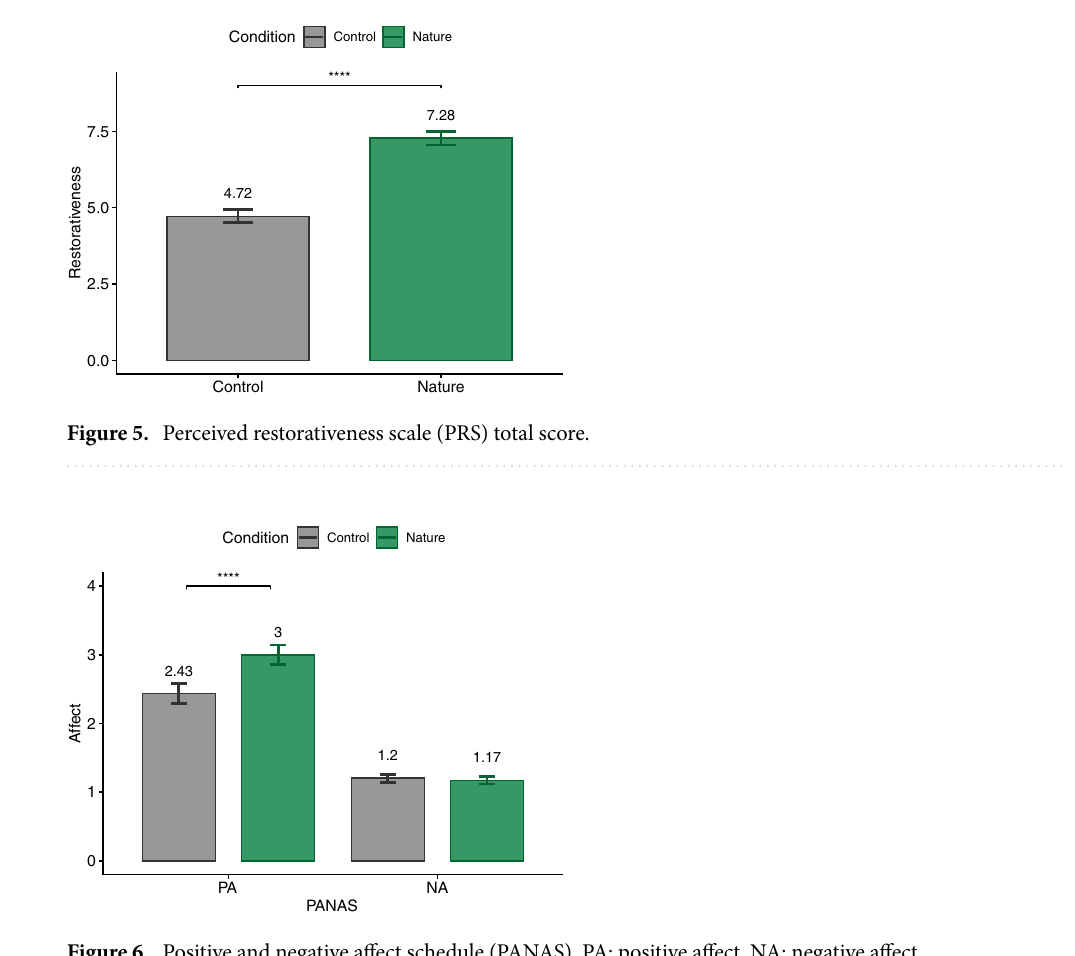
Figure 6. Positive and negative affect schedule (PANAS), PA: positive affect, NA: negative